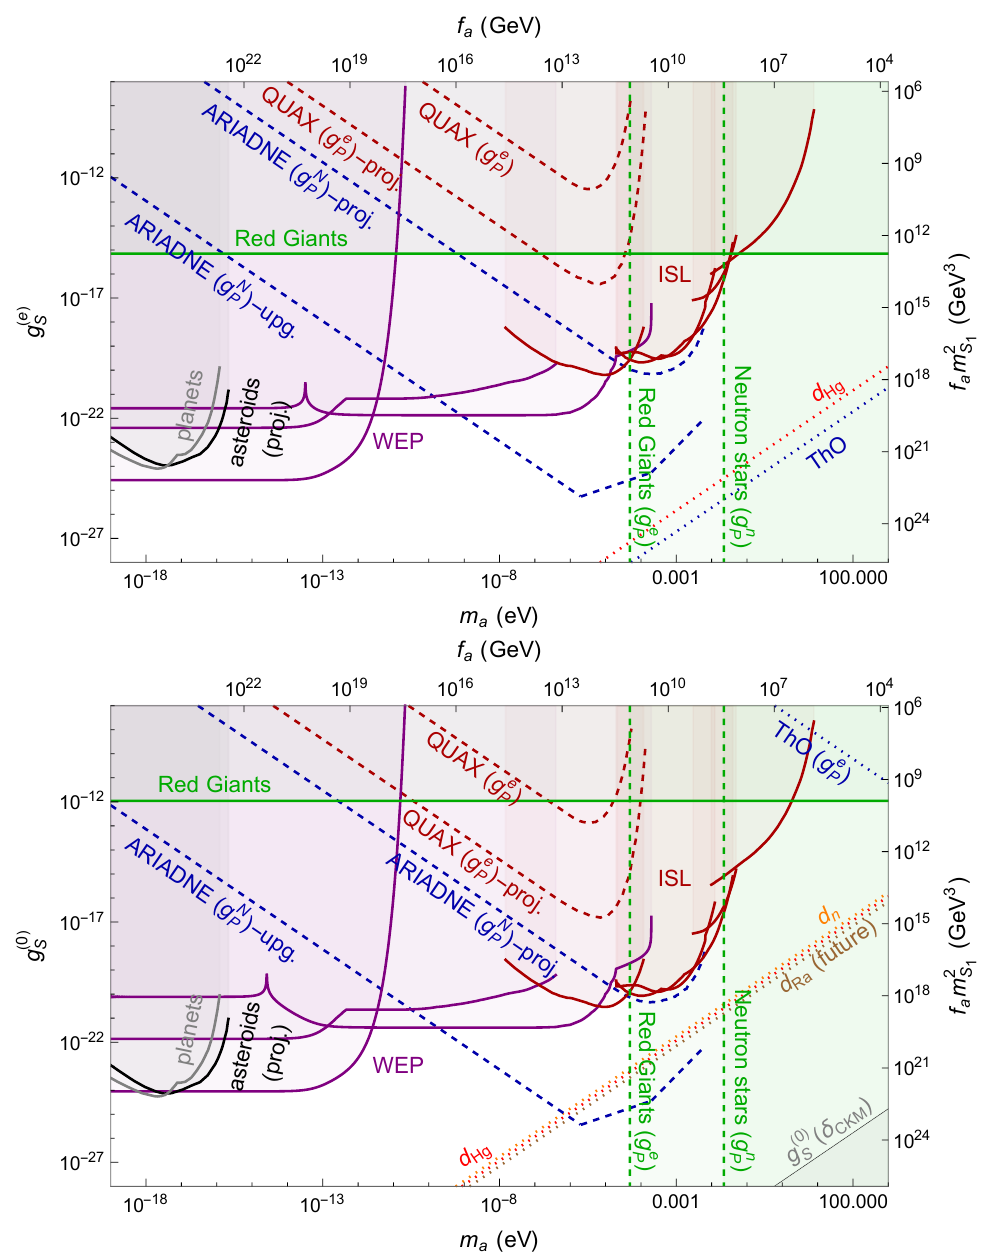
Figure 4 . Constraints on the axion-electron and isoscalar axion-nucleon coupling in the leptoquark scenario discussed in section 7.2. The top panel depicts the case in which semileptonic operators are induced by y = 0 while we set z = 0 . The bottom panel shows the inverted scenario LL,RR 6 LL,RR with y = 0 and z = 0 , which leads to hadronic four-quark interactions. To obtain the LL,RR LL,RR 6 mass scale, m , on right vertical axes we set the coupling constants to one, Im ( y ∗ S 1 Im ( z ∗ ) 11 z 11 = 1 , for the upper and lower panels, respectively. The CP-even axial axion-fermion LL RR couplings are chosen as in the DFSZ model with tan β = 1 . For an explanation of the various lines we refer to the caption of figure